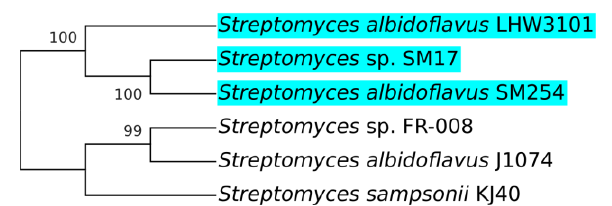
Figure 5. Consensus phylogenetic tree of the sur BGC region of the S. albidoflavus LHW3101 reference sur BGC sequence, plus five Streptomyces isolates determined to have sur BGC homologs, generated using MrBayes and Mega X, with a 95% posterior probability cut-off. Aquatic saline environment- derived isolates are highlighted in cyan.